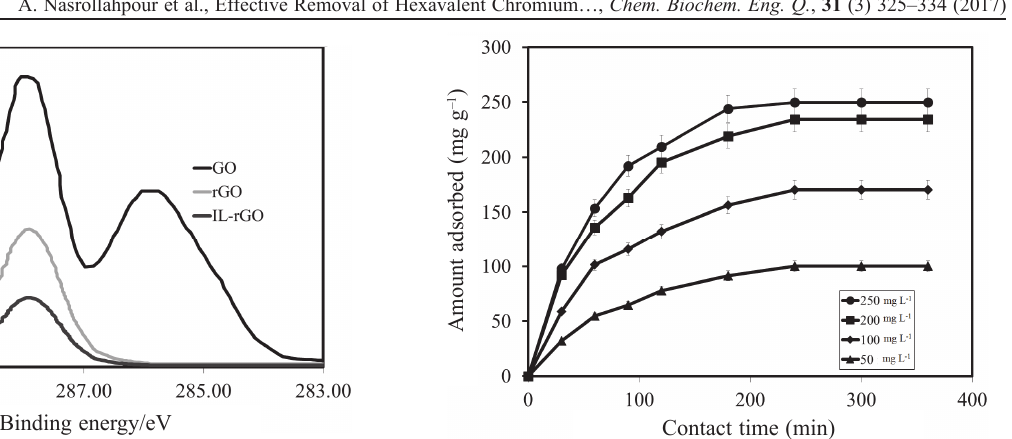
Fig. 3- Fig. 3 – XPS patterns of graphene oxide, reduced graphene Fig. 6 – Effect of initial concentration on removal of Cr(VI) Fig. 6- by IL-rGO (agitation speed = 250 rpm, contact time = 5 h, sorbent dosage = 0.5 g L –1 , temperature = 298 K and pH